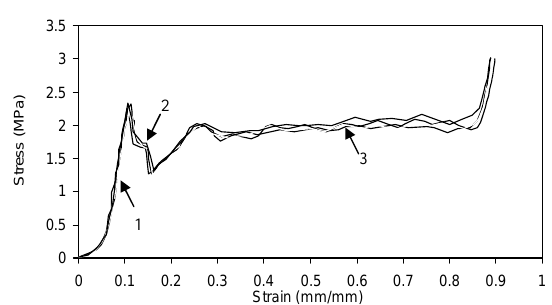
Fig. 10. Out-of-plane stress-strain curves for ACG Aluminum Hon- eycomb.